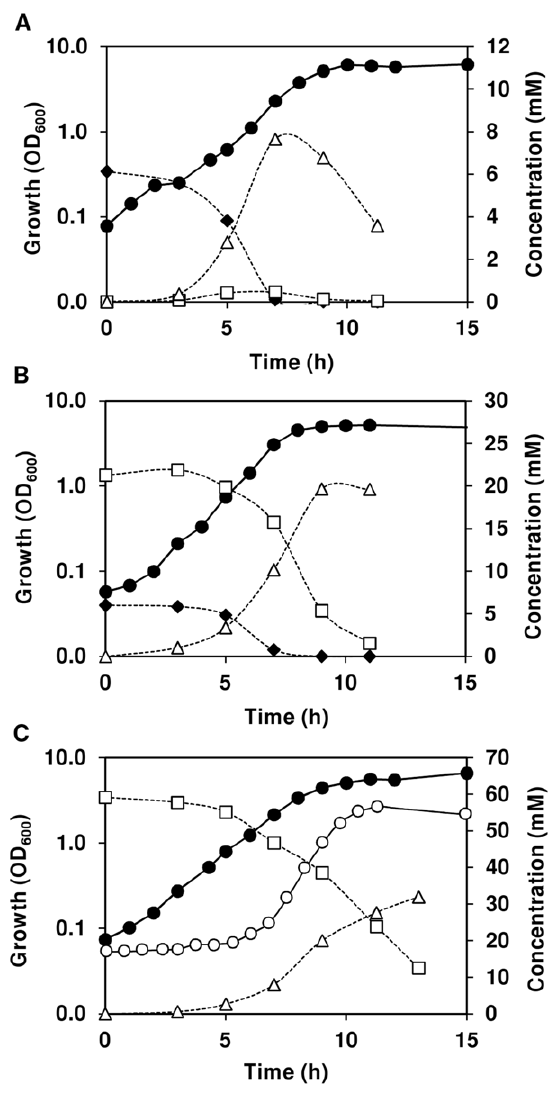
Figure 5. Lactate as a carbon source for aerobic growth of S. aureus . Growth, substrate consumption, and end-product formation by S. aureus COL-S using a limiting glucose concentration (A), a glucose/ lactate mixture (B), and lactate (C) as carbon sources in CDM and under aerobic conditions. Symbols: (black diamond), glucose; (open square), lactate; (open triangle), acetate; (black circle), growth in CDM with lactate (58 mM); (open circle) growth in CDM without additional carbon source. Data from a representative experiment where the error in each point # 10%.